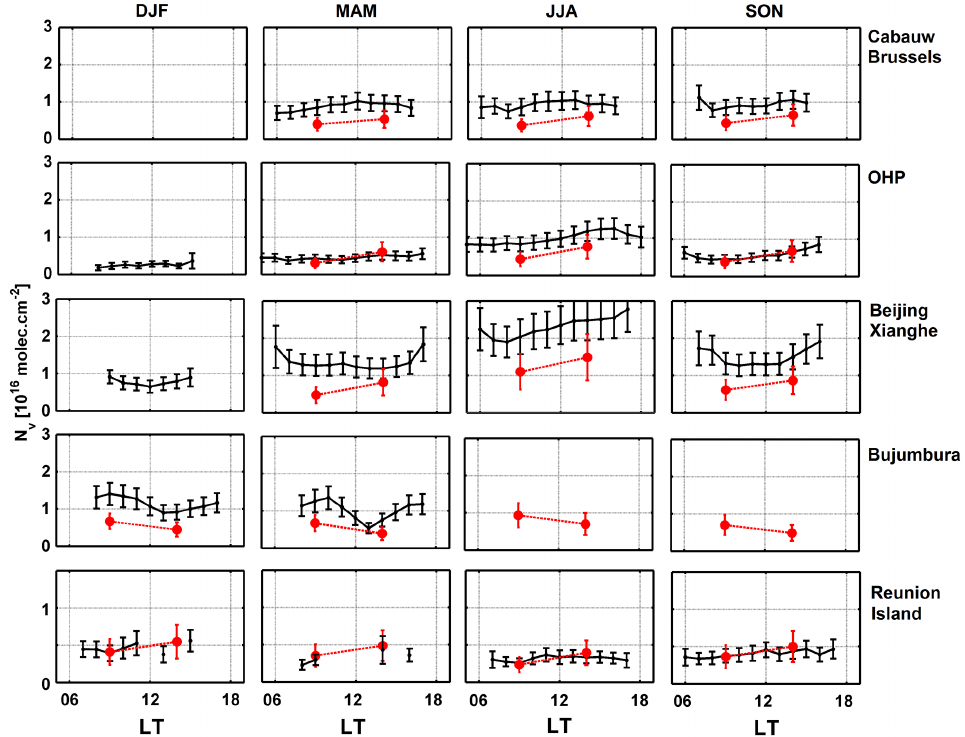
Figure 10. Mean seasonal and diurnal variations of the H 2 CO columns as observed by MAX-DOAS or FTIR instruments (in black) and by GOME-2 and OMI (in red). Values are shown for five regions where BIRA-IASB operates ground-based measurements: Cabauw and Brussels (northern Europe), OHP (southern France), Beijing and Xianghe (north-eastern China), Bujumbura (central Africa) and Reunion (southern Africa). Satellite measurements have been averaged within 100km around each location, and filtered using quality criteria as defined in Sect. 3.4. Details of the ground-based measurements are summarised in Table